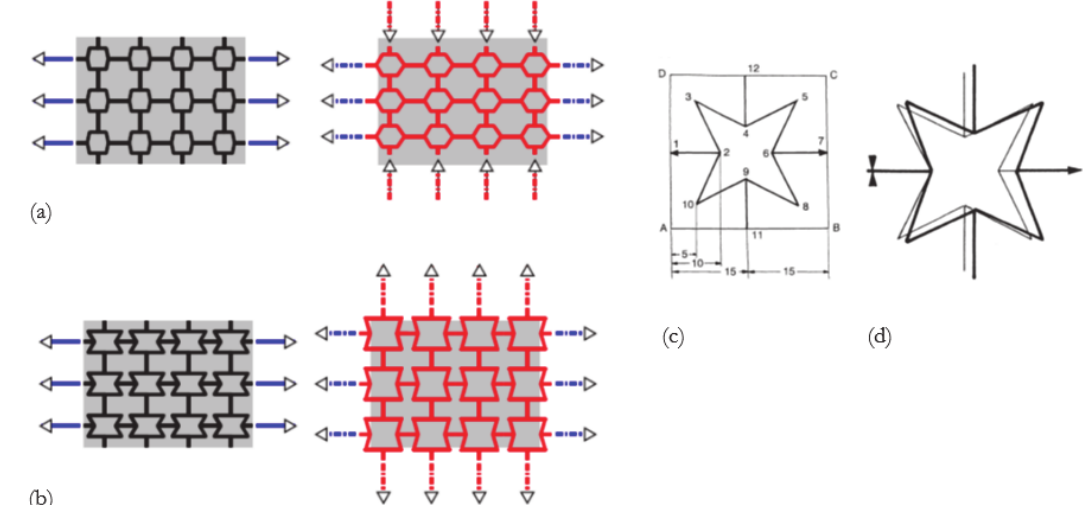
Figure 1: (a) Conventional, (b) Auxetic behaviour of microstructures based on their internal substructure, (c) Star-shaped, two- dimensional representative auxetic cell (d) Deformation of the star-shaped